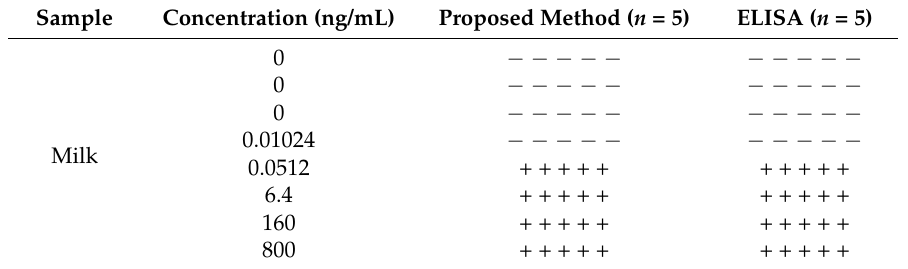
Figure 6. Practical applications of the handheld inkjet printing paper chip based smart tetracycline detector on detecting tetracycline in milk using the proposed technique. The numbers on the columns represent standard deviations computed from 5 measurements. The dotted line indicates the signal at the detection limit. Table 3. Detection on tetracycline in milk using the proposed method and commercial ELISA kit.